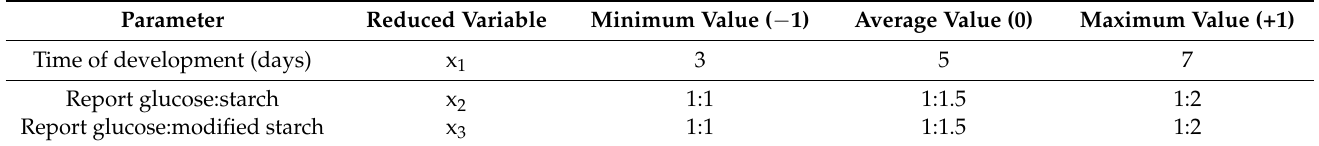
Table 1. Parameters considered and their field of variation.